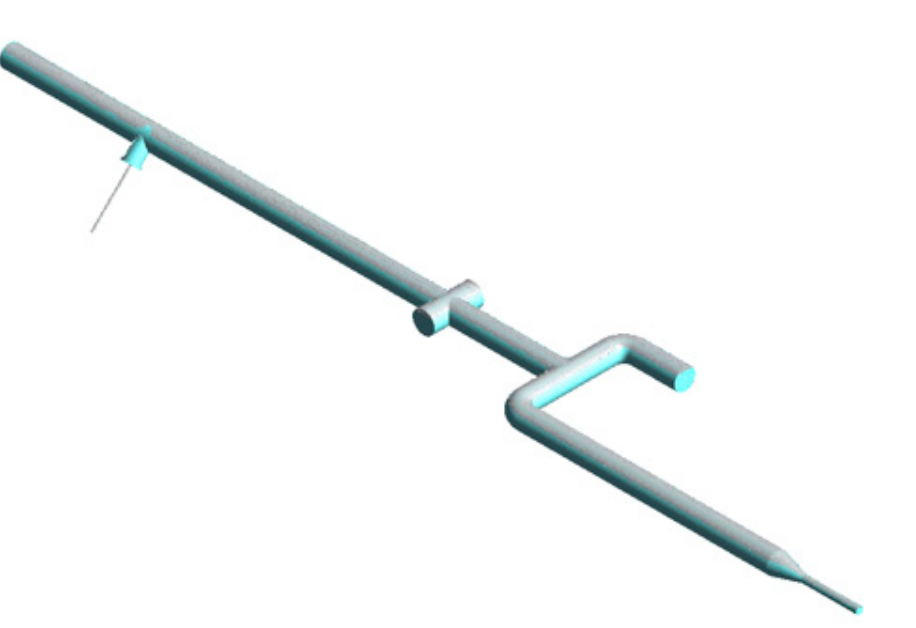
Figure 7. The gas distribution in the experiment study setup before the CFMs.